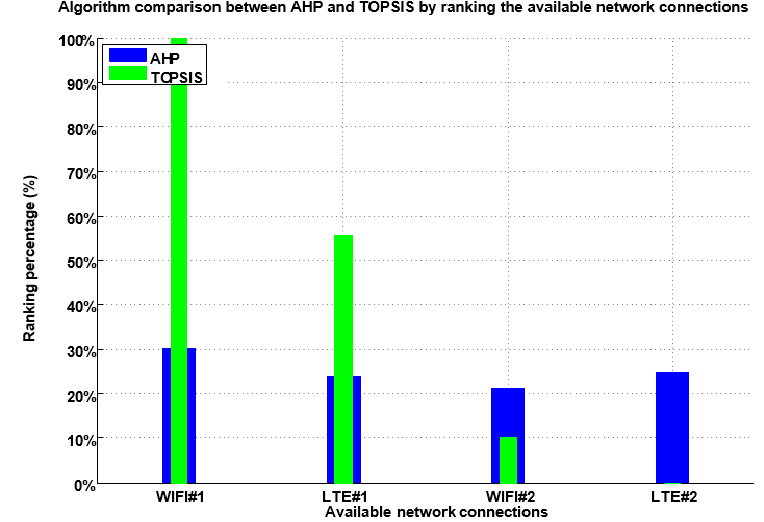
Figure 9. Comparison of network connections utilization based on the proposed model versus the TOPSIS algorithm.